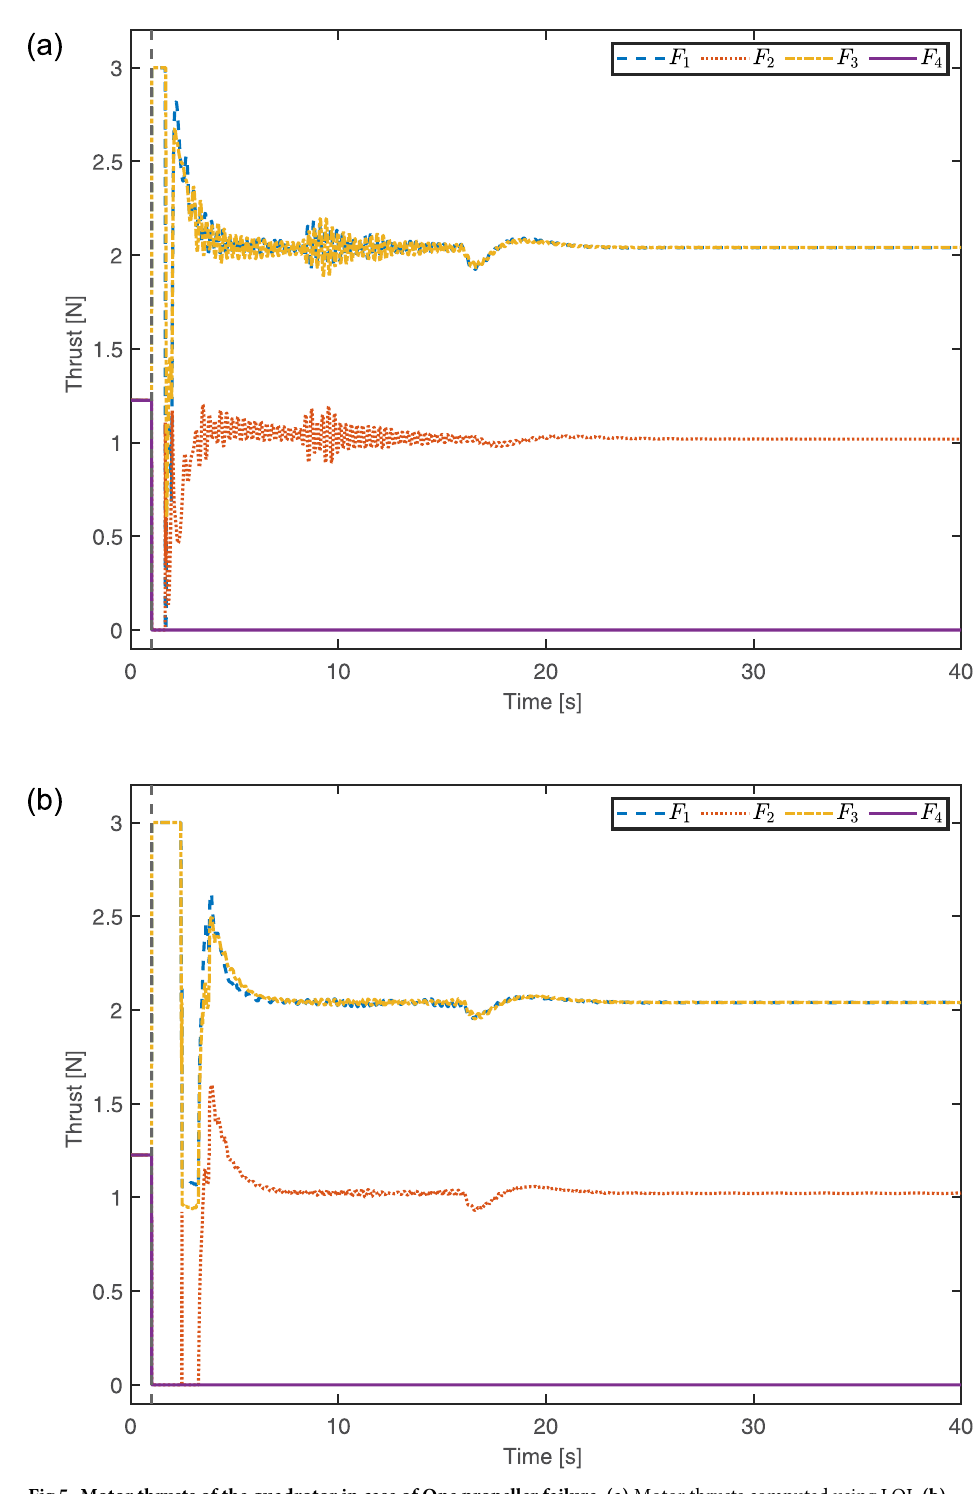
PLOS ONE | https://doi.org/10.1371/journal.pone.0282055 March 3,